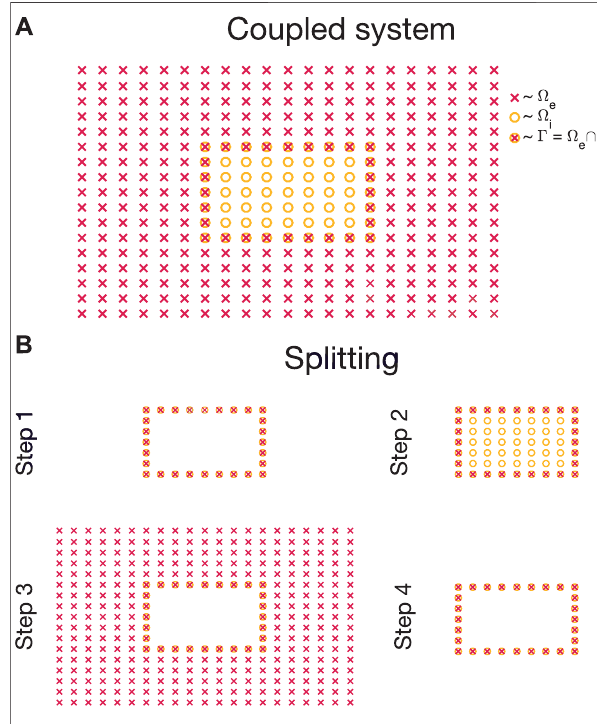
Frontiers in Physics |